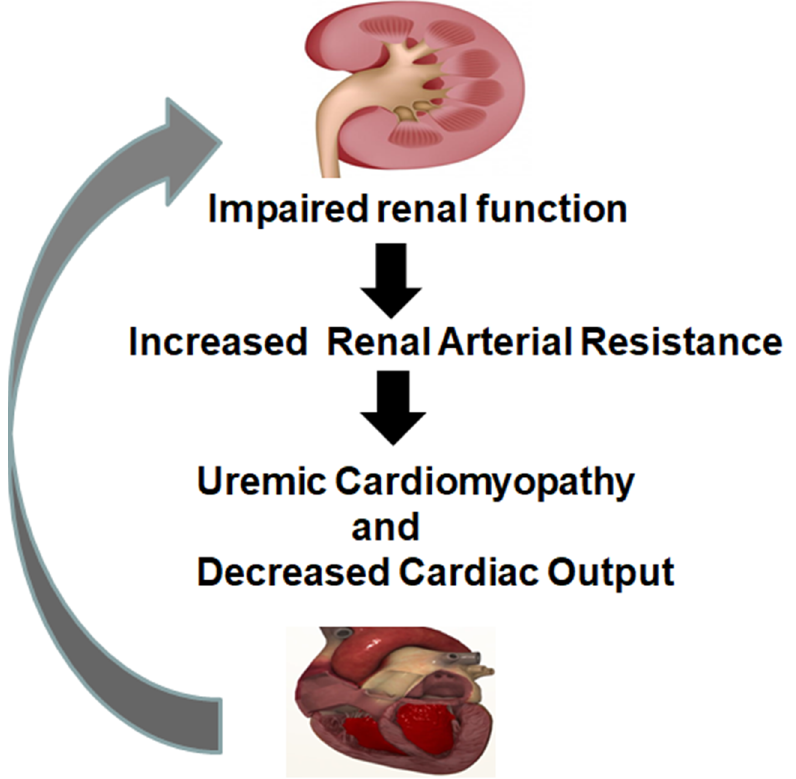
Figure 6. Link between Renal-Cardiomyopathy and heart failure.